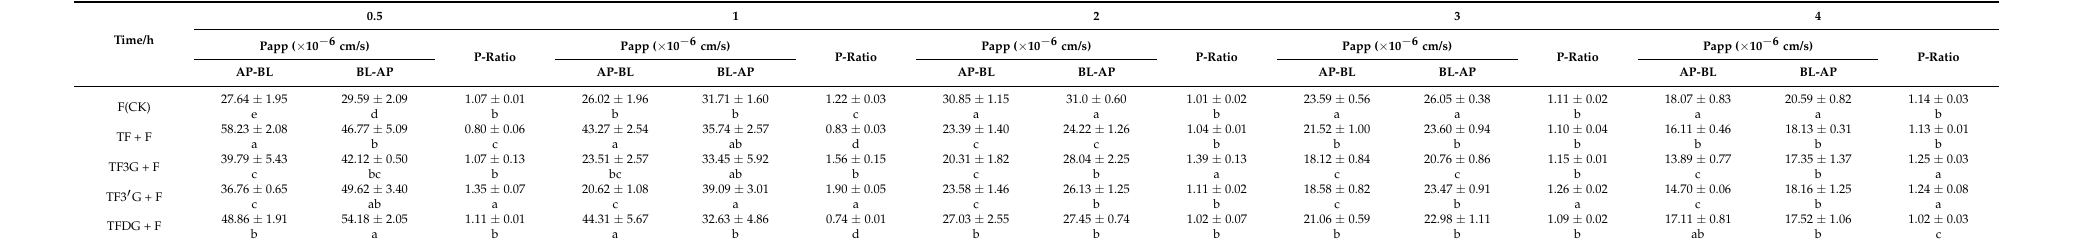
Table 1. Effects of TFs on the apparent permeability coefficient of F − transport in Caco-2 cells at different treatment time points.